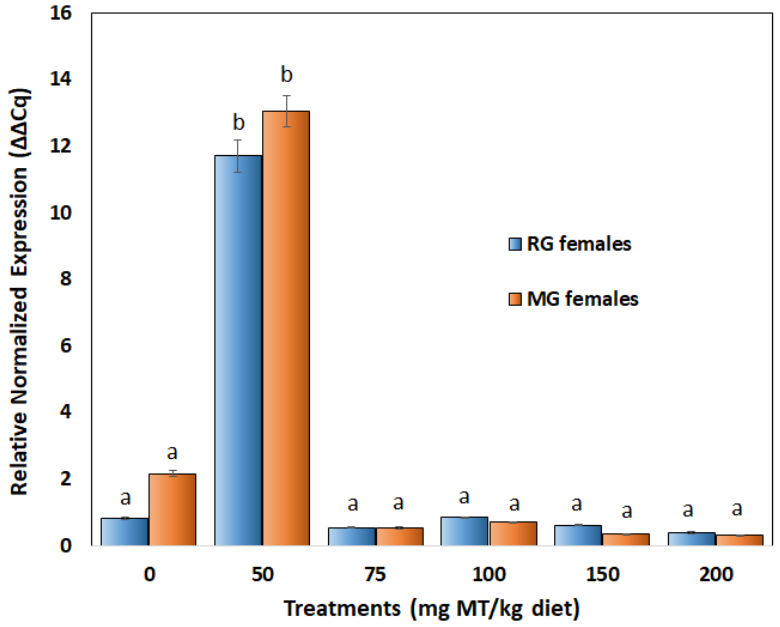
Figure 10. Relative normalized amh expression (∆∆Cq) in gonads of RG and MG females of G. holbrooki treated with MT (0 to 200 mg/kg). The data are presented as mean ± standard error ( n = 3 per treatment). Means with different letters are significantly different from one another.